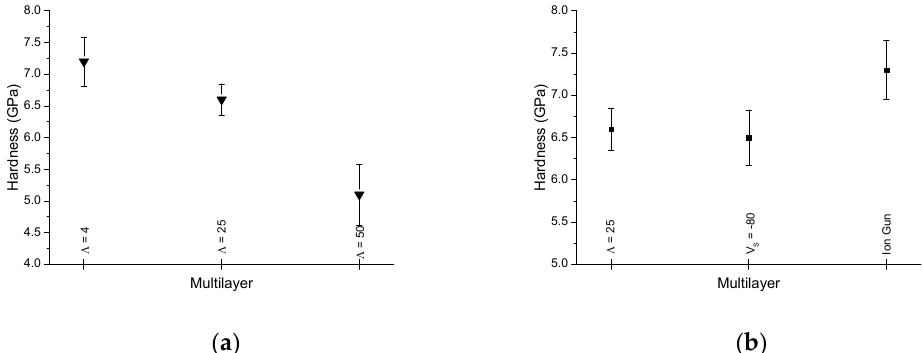
Figure 9. Hardness of the Al/Ni (V) multilayer thin films: ( a ) influence of the period; ( b ) influence of